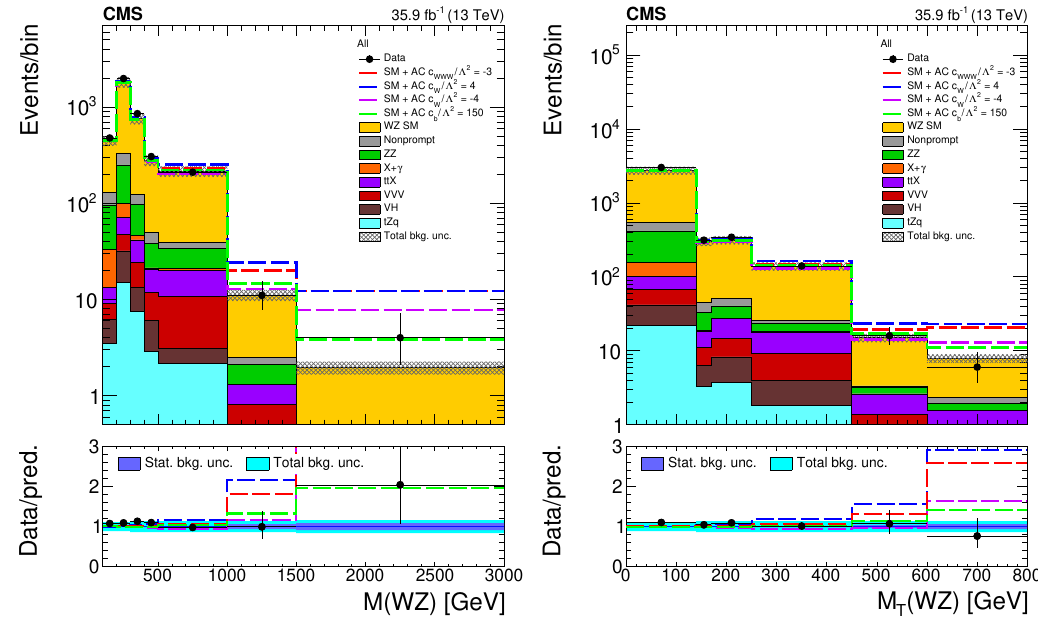
Figure 15 . Distributions of discriminant observables in the anomalous triple gauge couplings searches, before the (cid:12)t used to determine con(cid:12)dence regions on the couplings. The invariant mass of the three lepton and missing transverse momentum system (left) and the transverse mass of the same con(cid:12)guration (right). The dashed lines represent the total yields expected from the sum of the SM processes, with the total WZ yields for di(cid:11)erent values of the associated anomalous coupling (AC) parameters. The SM prediction for the WZ process is obtained from the aTGC simulated sample with the AC parameters set to